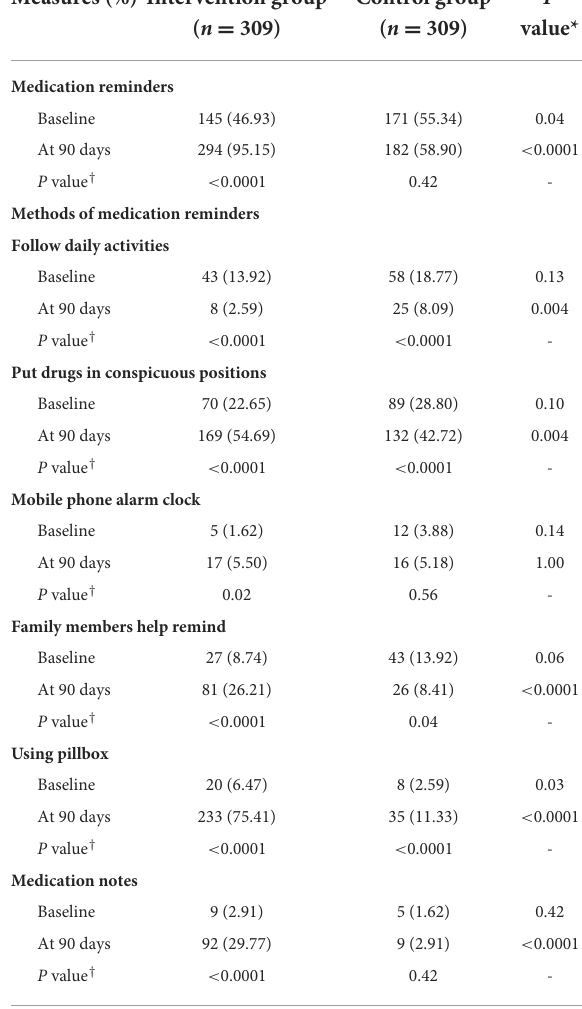
TABLE 3 Medication reminders and its methods for elderly patients with multimorbidity. Measures (%) Intervention